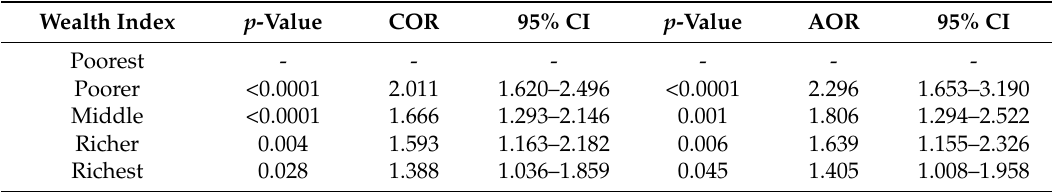
Table 4. Association between household wealth index and positive estimation of overall happiness in life, Nepal MICS 2014.